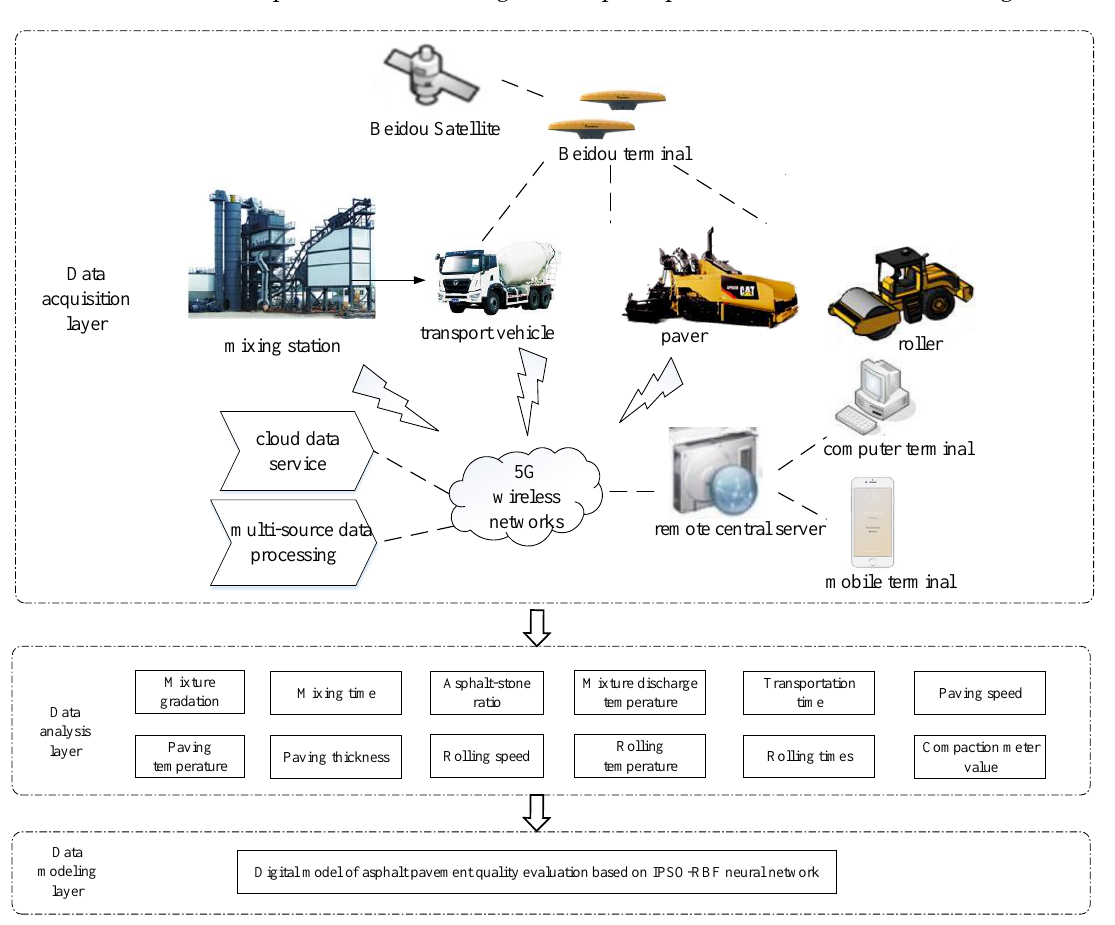
Figure 1. Structure diagram of the digital monitoring system for measuring asphalt pavement construction quality.